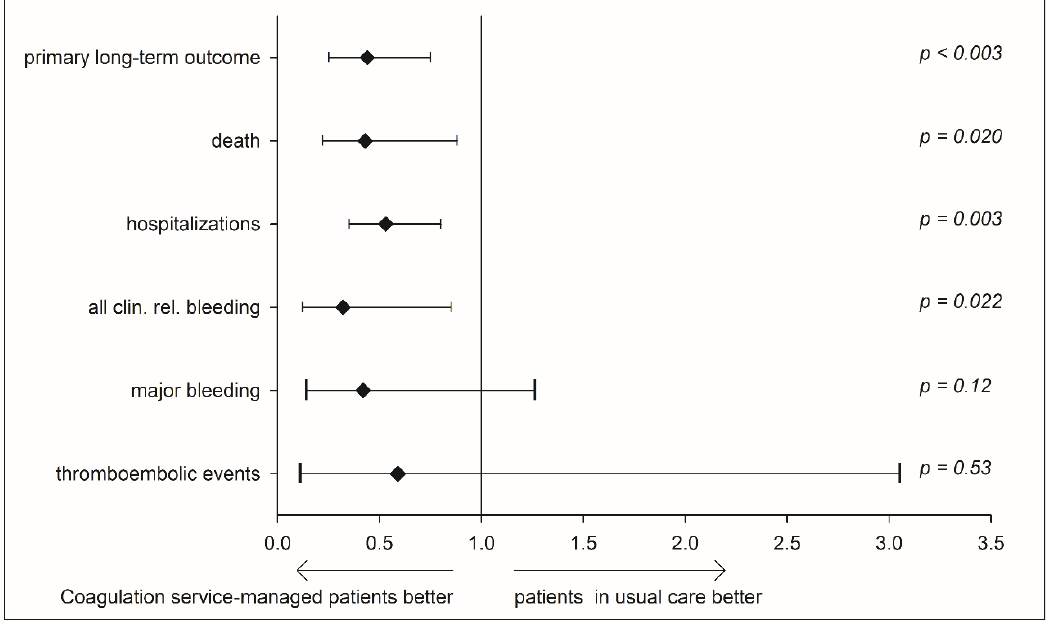
Figure 2. The adjusted safety endpoints and outcome measures comparing severe renal failure patients in a coagulation service with those receiving usual medical care, Cox regression. Forest plot showing the rate ratios and 95% confidence intervals of endpoints; primary long-term outcome: composite endpoint of clinically relevant non-major and major bleeding, myocardial infarction, systemic and pulmonary embolism, stroke, and death. Adjusted for age, sex, and cardiovascular risk factors.